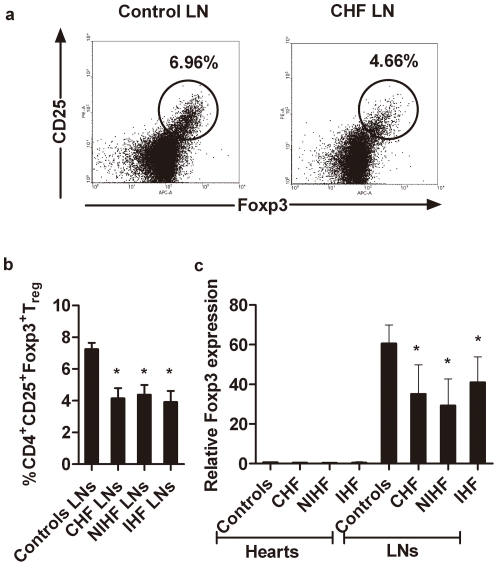
Treg cells in mediastinal lymph nodes and hearts.a. Representative FACS dot plots showed the presence of CD4+CD25+Foxp3+ Treg cells in the mediastinal lymph nodes. b. Percentages of CD4+CD25+Foxp3+ Treg cells in the mediastinal lymph nodes were determined in six CHF patients (three with idiopathic cardiomyopathy and three with ischemic cardiomyopathy) and three controls without cardiomyopathy. c. Comparison of Foxp3 expression in the mediastinal lymph nodes and hearts of CHF and non-CHF controls. *p<0.05 vs. non-CHF controls.